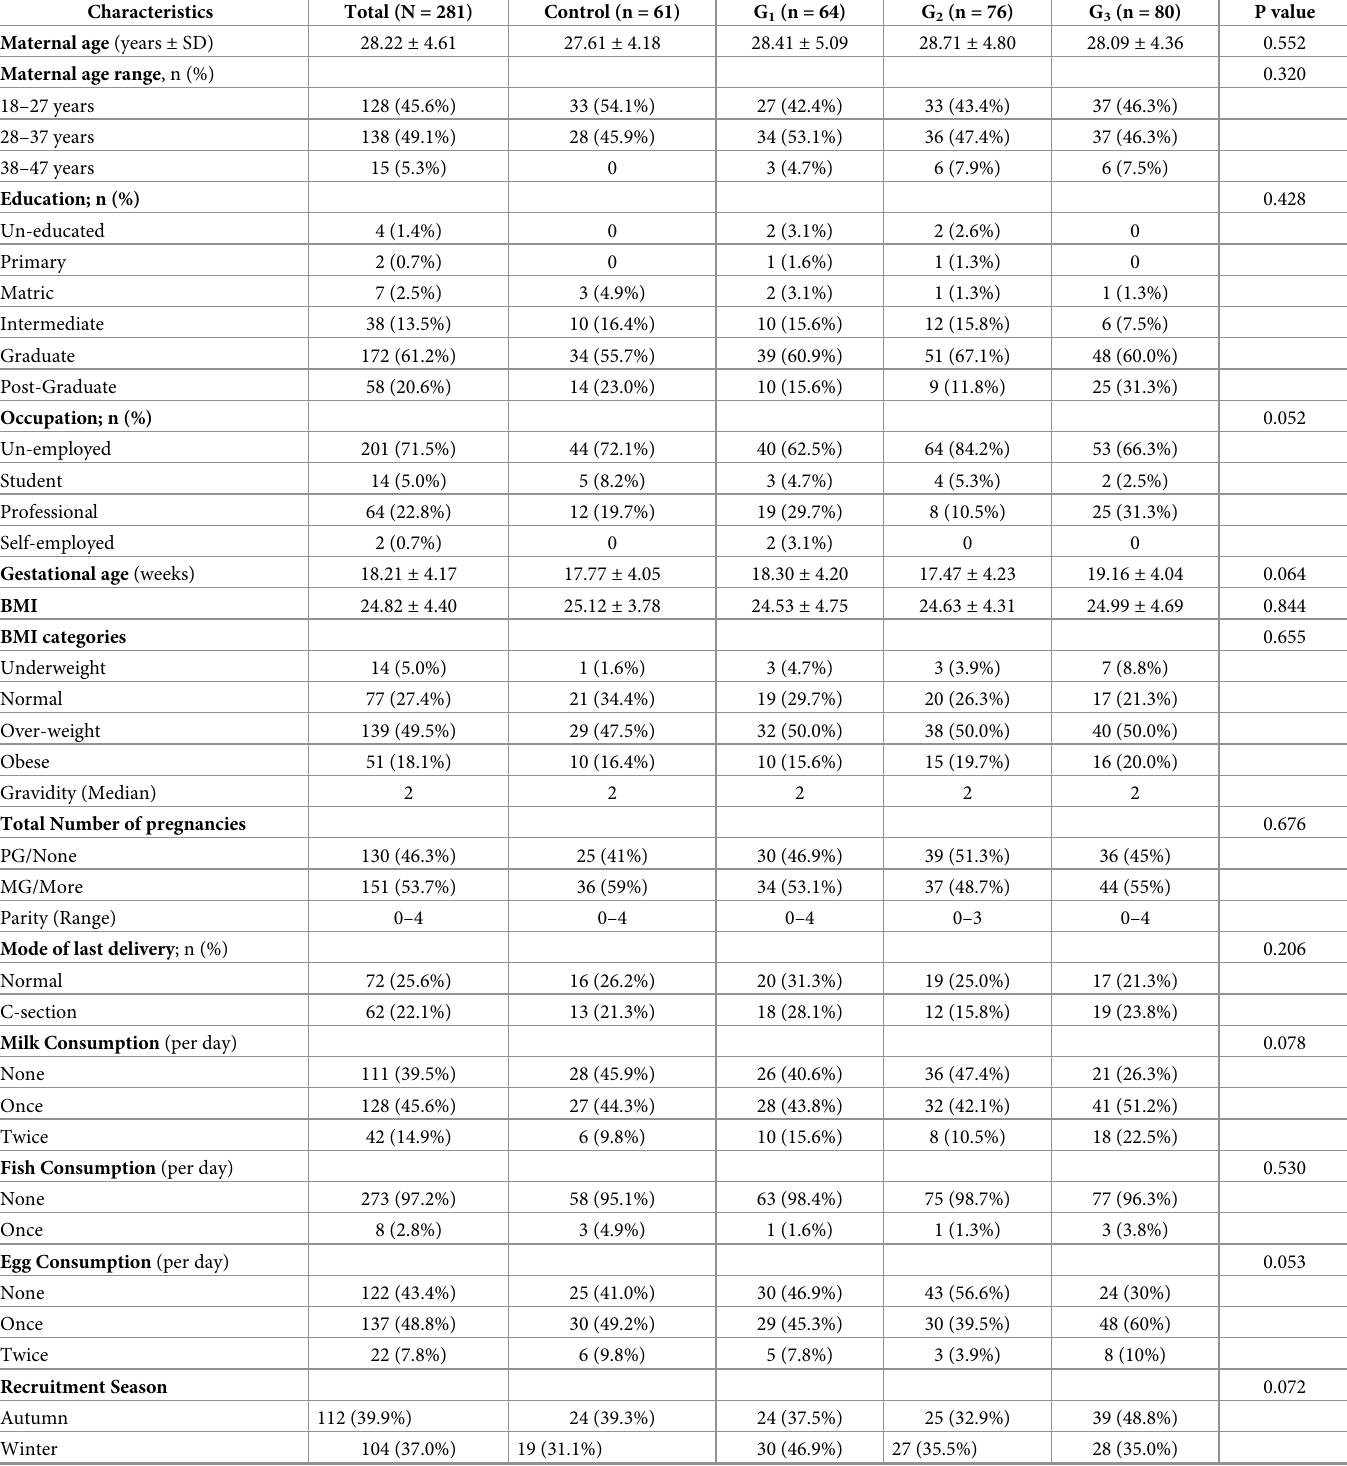
Table 1. Demographic characteristics of the treatment groups recorded at